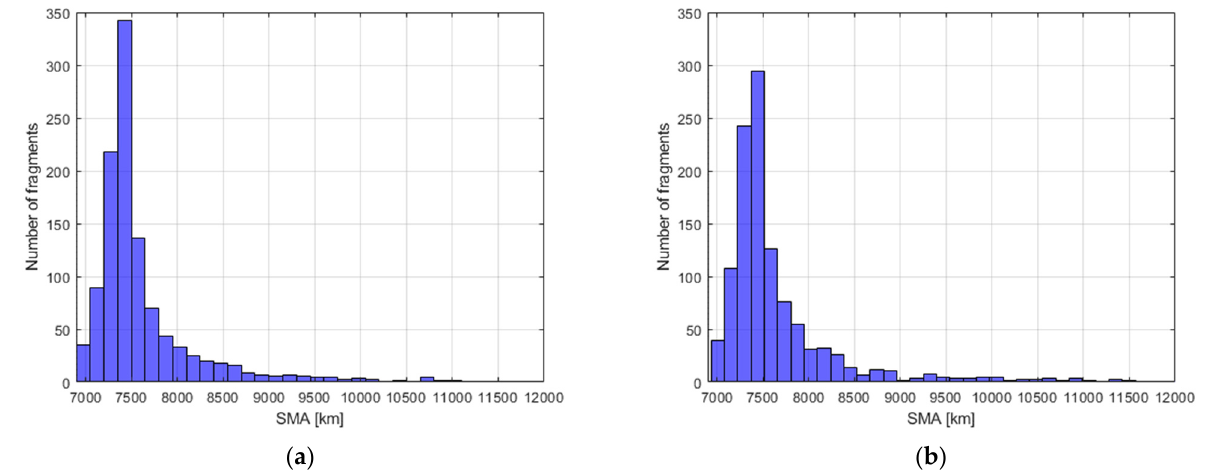
Figure 9. Histograms of reference ( a ) and estimated ( b ) fragments in range [6900, 12,000] km of semimajor axis for first test case.